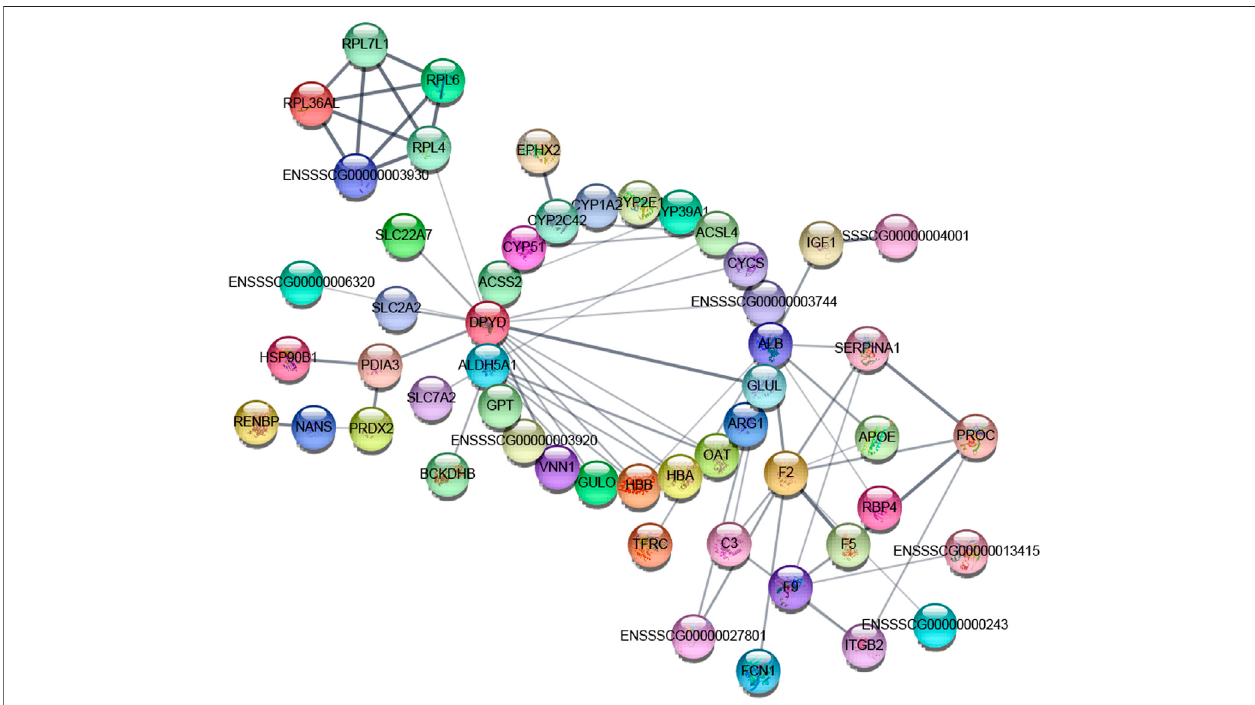
FIGURE 12 | Interaction of differentially expressed proteins: the node in the graph is a protein, and the edge is interaction. The thickness of the edge in the interactionnetworkindicatesthestrengthoftheinteractionbetweenthetwonodesconnectedbytheedge,andthereisnoknowninteractionbetweentheunconnected protein